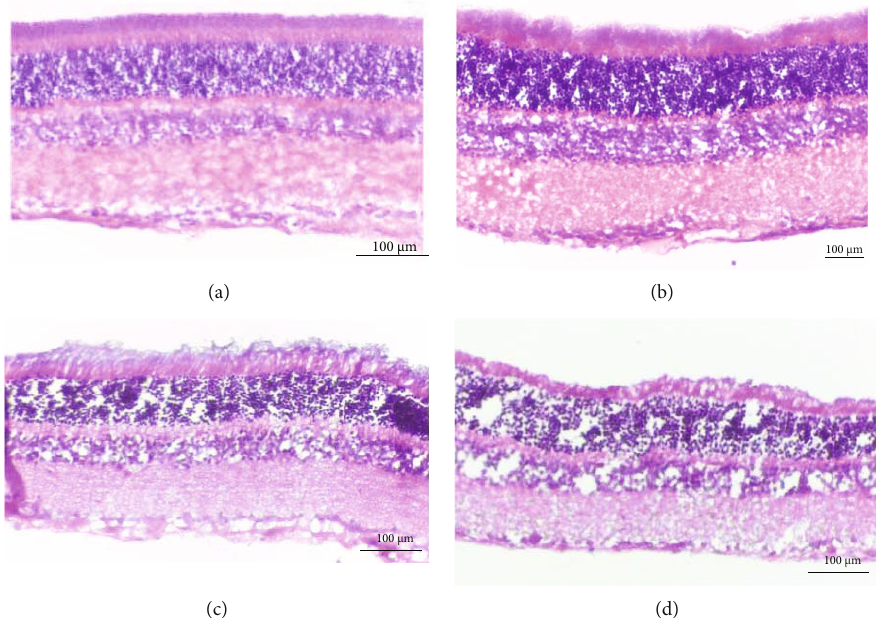
Figure 2: Histology of HE-stained sections in diabetic rats: (a) control; (b) 4 weeks; (c) 8 weeks; (d) 16 weeks. After 8 and 16 weeks, mild thinning of the inner layers of the retina was